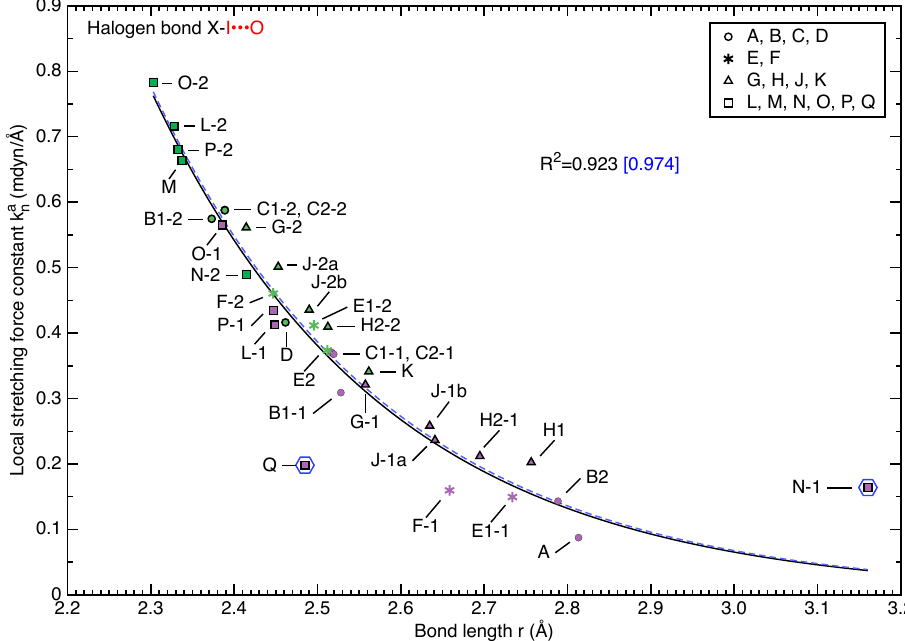
Figure 4. Relationship between local stretching force constant k a n and bond length r for Cl-I · · · O (green) and I-I · · · O (purple) halogen bonds, respectively. Data points are shown with 4 shapes based on the acceptor molecule type, see Figure 1. An exponential function in the form of k a n = a · exp ( b · r ) was used to fit all 34 data points with R 2 = 0.923. Two data points are identified as outliers (encircled by blue hexagons) and R 2 = 0.974 is obtained for fitting the remaining 32 data points. The blue dashed curve shows the updated fitting function excluding two